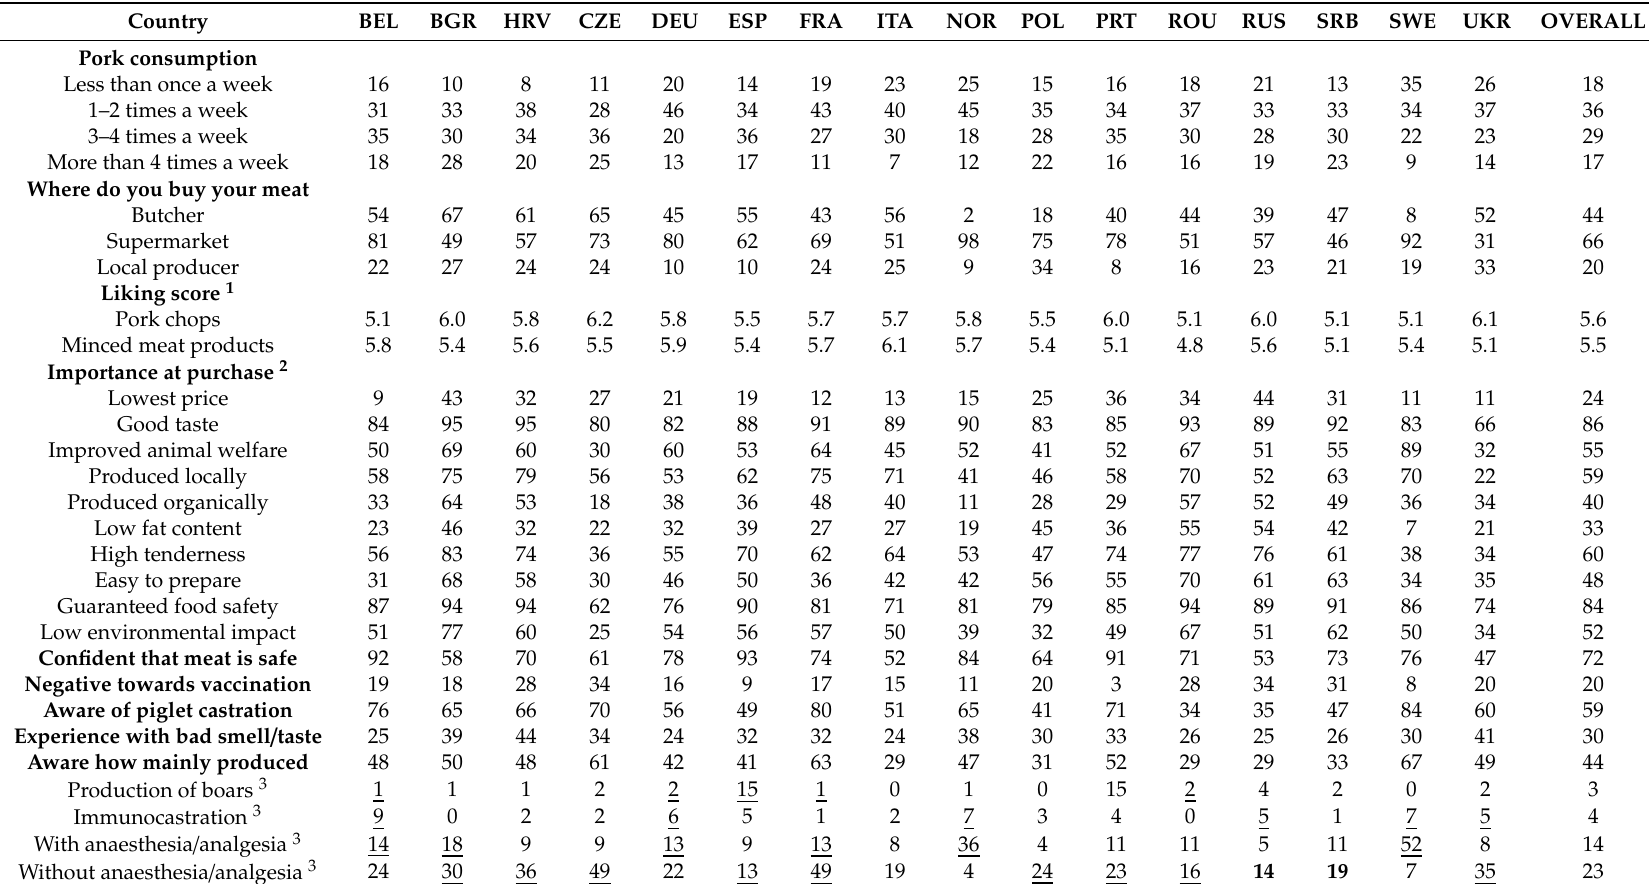
Table 2. Pork consumption characteristics, background knowledge, and experience of the respondents by country and